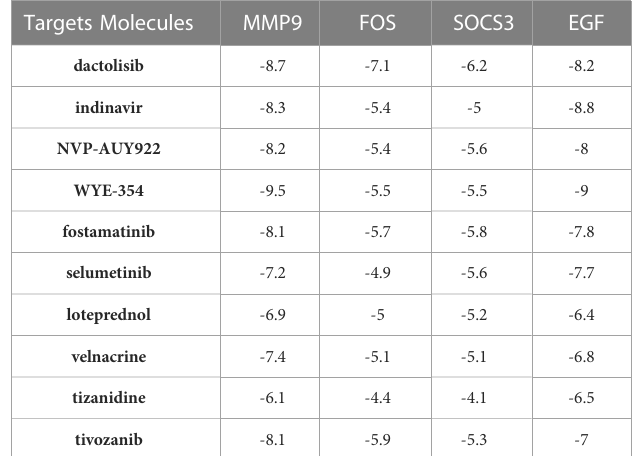
TABLE 2 Binding energy for molecular